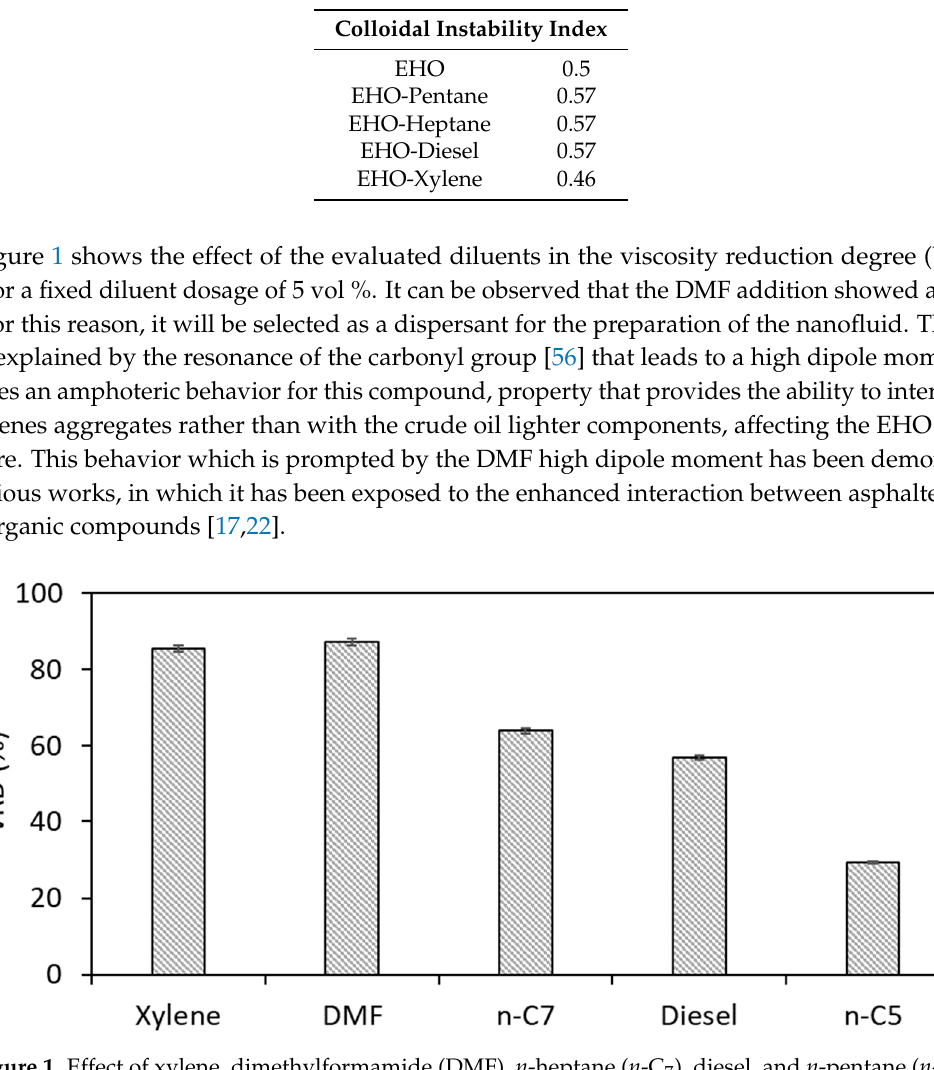
Figure 1. Effect of xylene, dimethylformamide (DMF), n -heptane ( n -C 7 ), diesel, and n -pentane ( n -C 5 ) in the viscosity reduction degree (VRD) of an extra-heavy oil at 30 ◦ C for a fixed diluent dosage of 5 vol % at a fixed shear rate of 10 s − 1 .